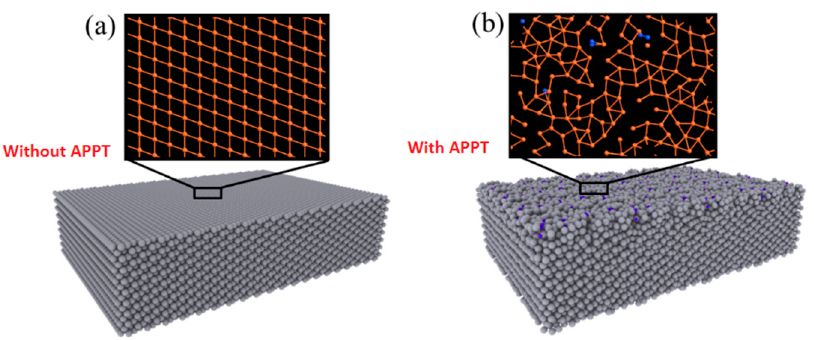
Figure 10. Stacking structure of Fe atoms: ( a ) without and ( b ) with APPT.